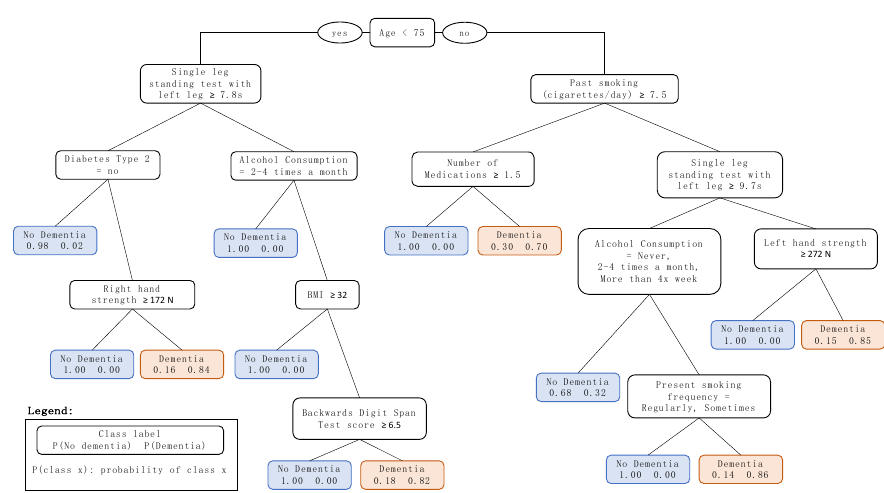
Figure 2. Resulting decision tree model for the prediction of dementia in 10 years. Throughout the decision tree, the left branches refer to ‘yes’ with regard to the rule of the node, and the right branches refer to ‘no’. Table 4. Description and possible values of the variables identified by the proposed decision tree approach.